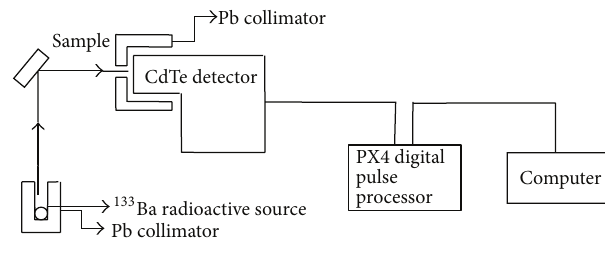
Figure 1: The experimental setup.